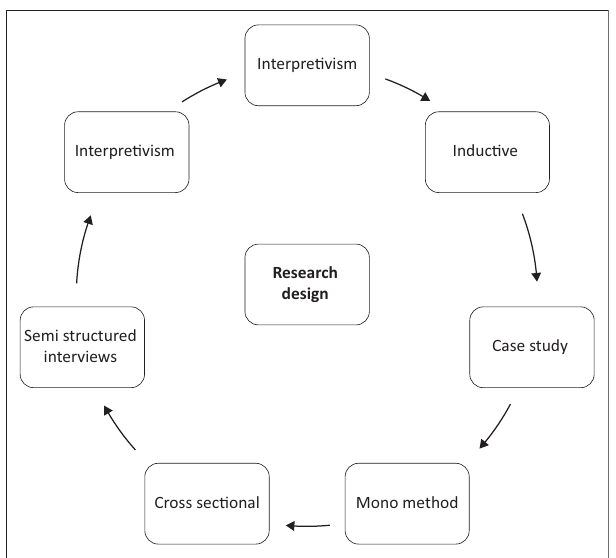
FIG URE 4: Research design of the